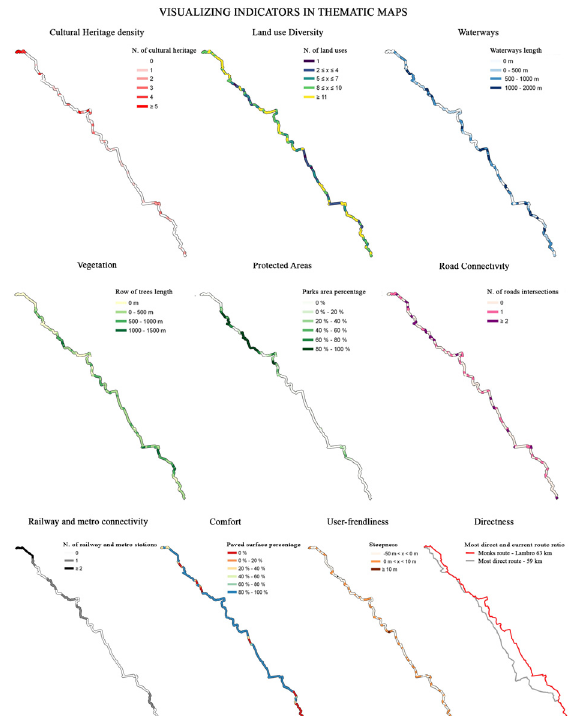
Figure 2. Visualizing indicators in thematic maps. The variation of spatial features along the route has been represented through color ramps. Case study: Monks route – Lambro.